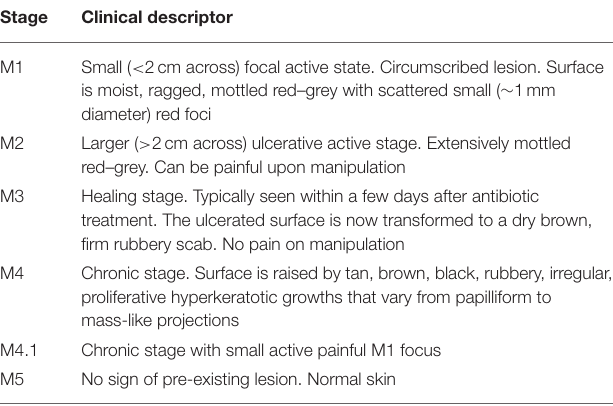
TABLE 1 | Classification of digital dermatitis lesions according to macroscopic